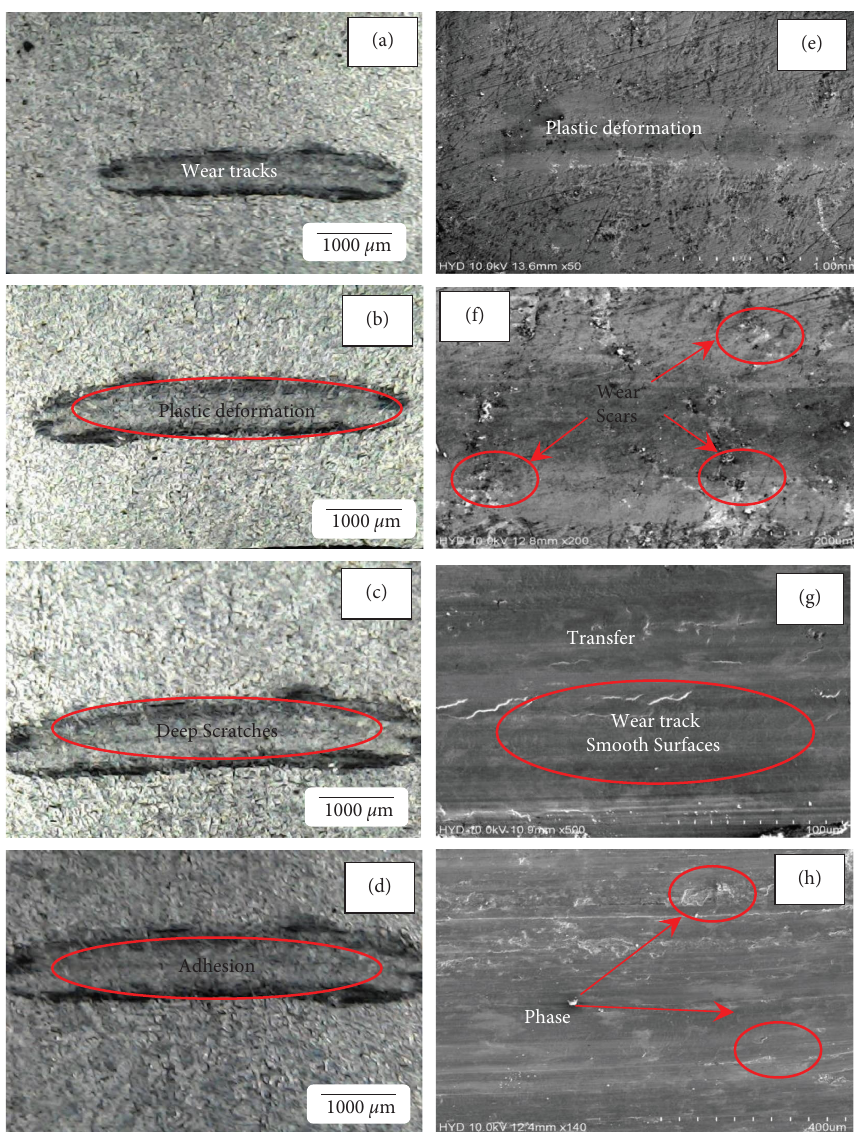
Figure 13: Micrographs of HAlSi24 under DLC-coated condition at (a) 20N, (b) 30N, (c) 40N, and (d) 50N. Morphology of HAlSi24 under DLC-coated conditions at (e) 20N, (f) 30N, (g) 40N, and (h)